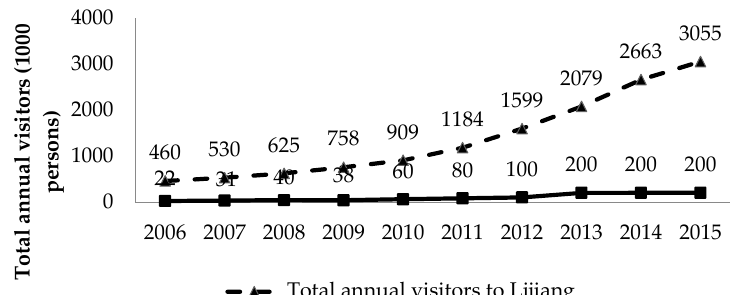
Figure 3. Development of tourism in Lijiang and Lashi Township.